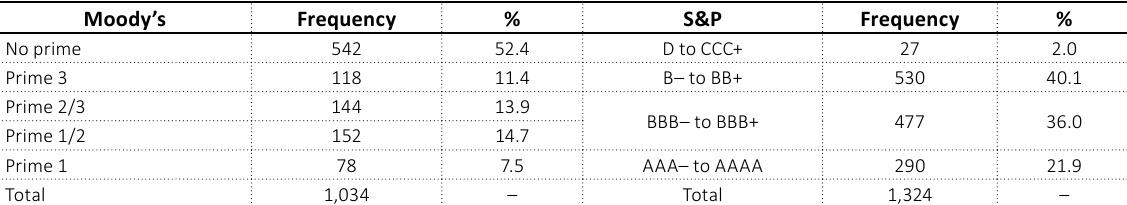
Table 6. S&P and Moody’s